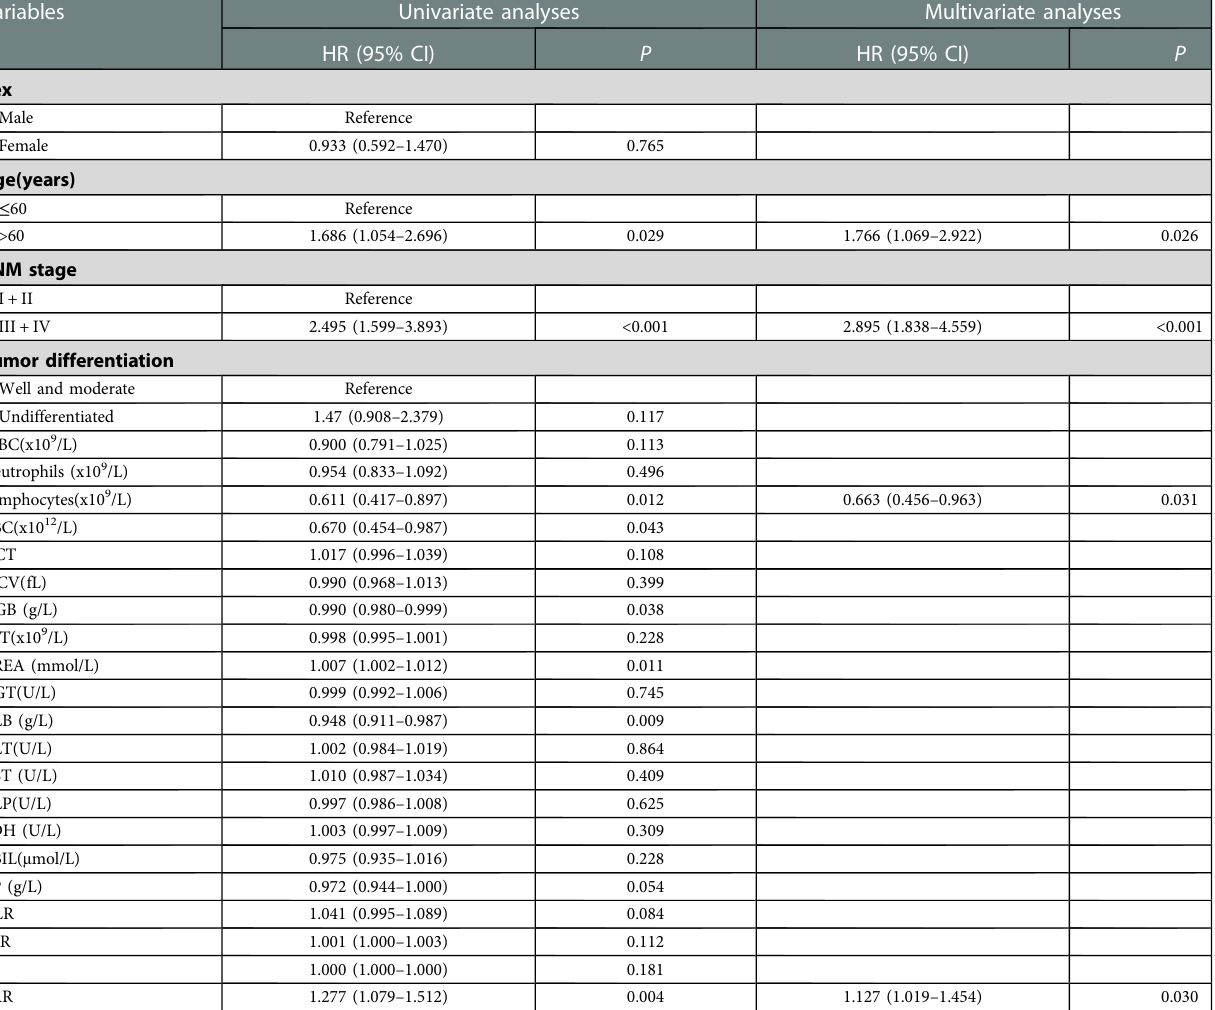
TABLE 4 Univariate and multivariate analyses of OS in training cohort.